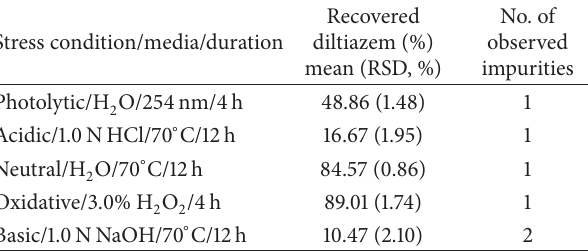
Table 1: Summary of stress degradation studies of